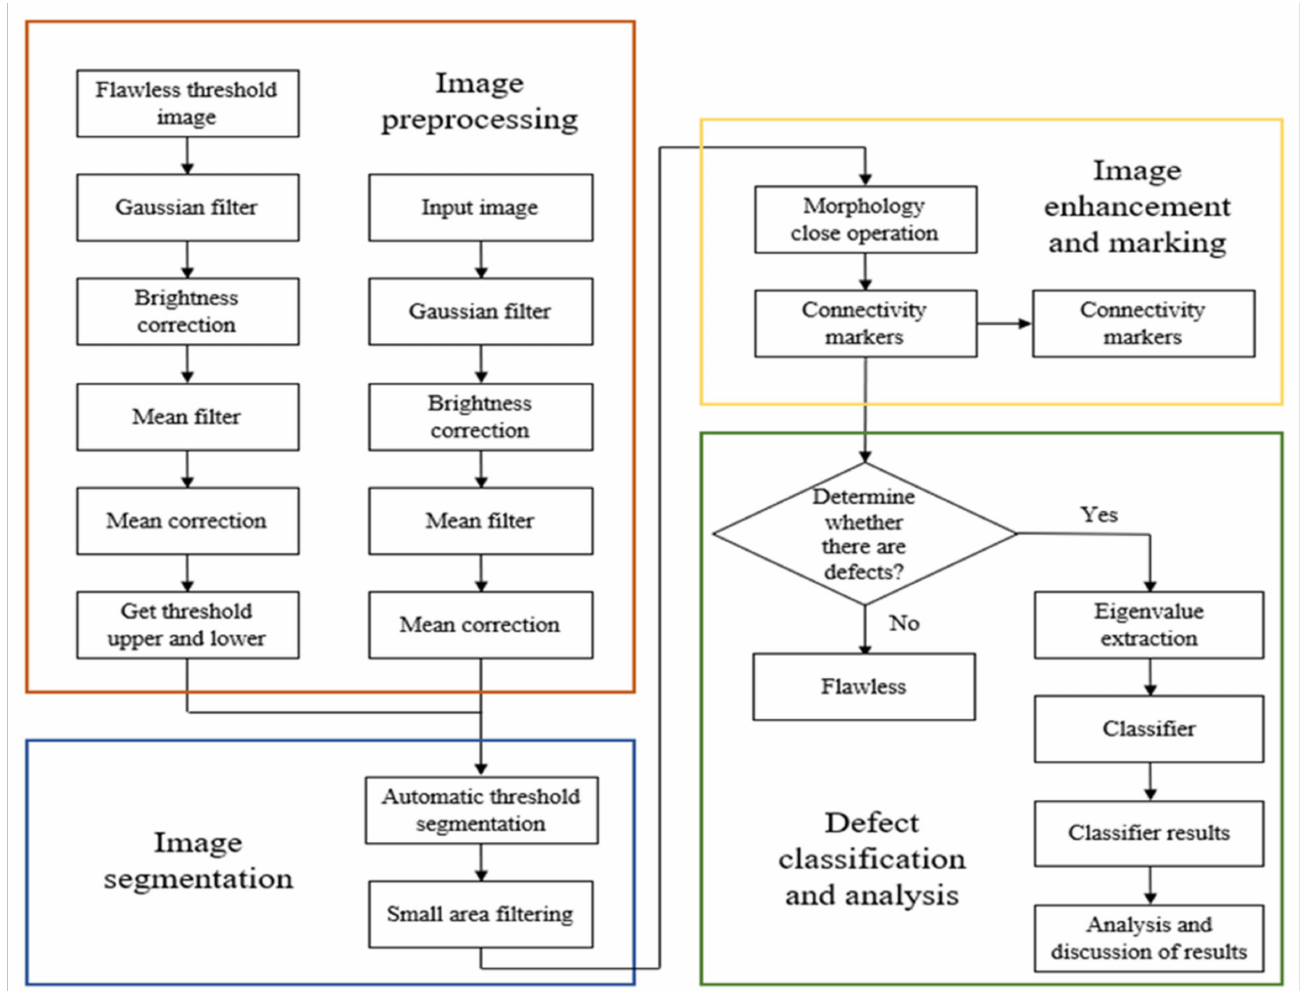
Figure 9. Image processing flow